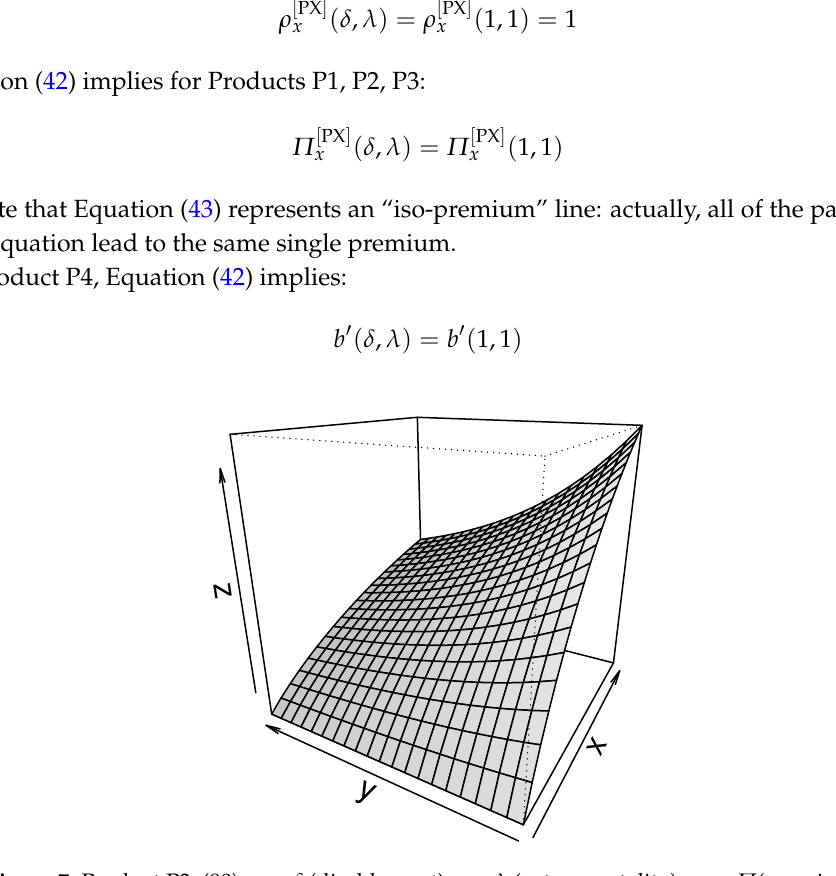
Figure 7. Product P3a(80); x = δ (disablement), y = λ (extra-mortality), z = Π